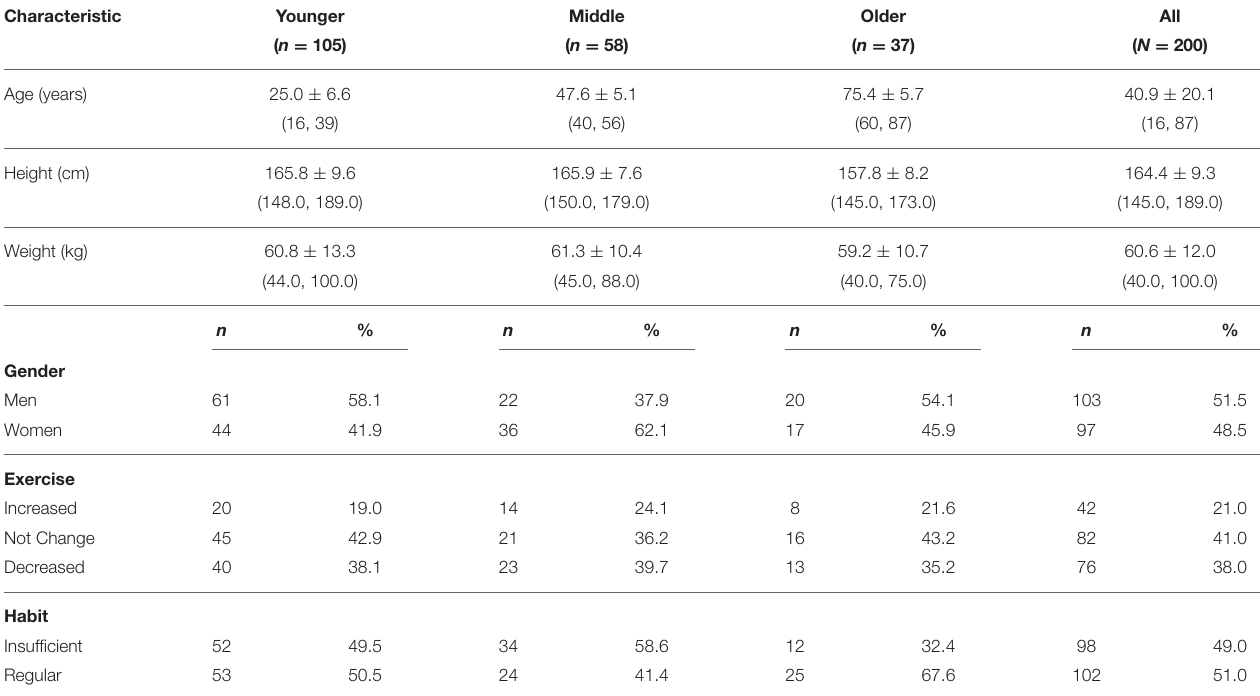
TABLE 1 | Characteristics of the three age-based groups.